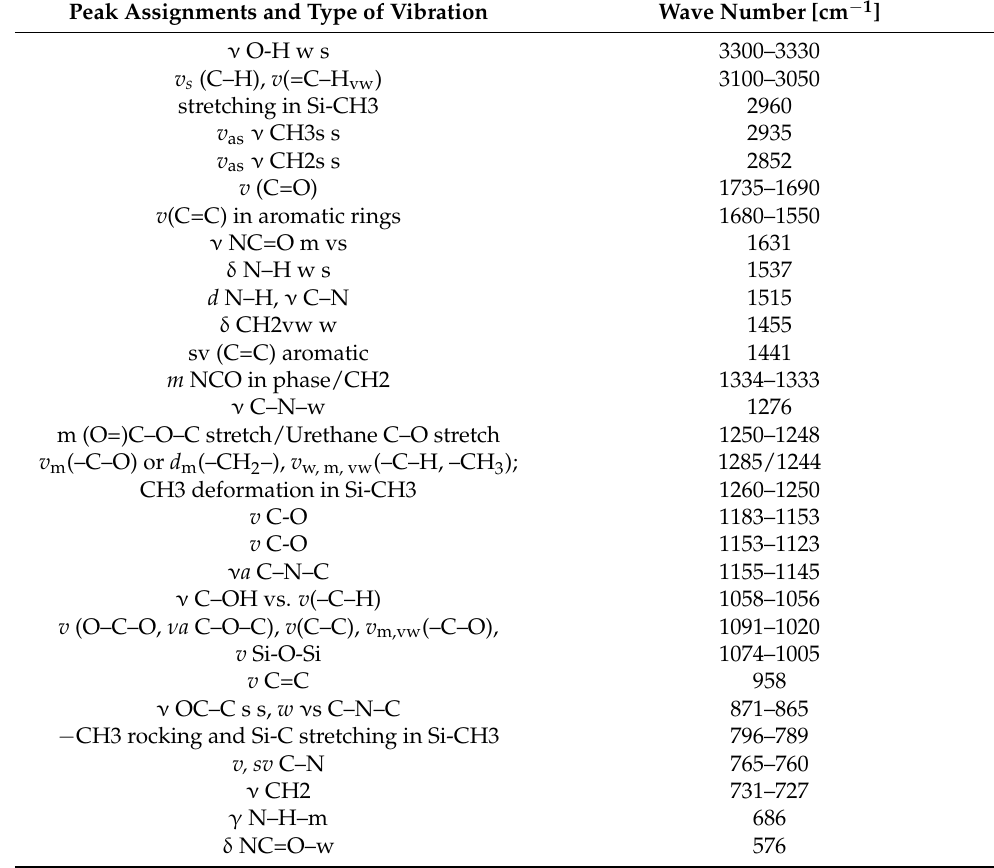
Table 2. Characteristic functional groups registered by FTIR analysis of the analyzed samples